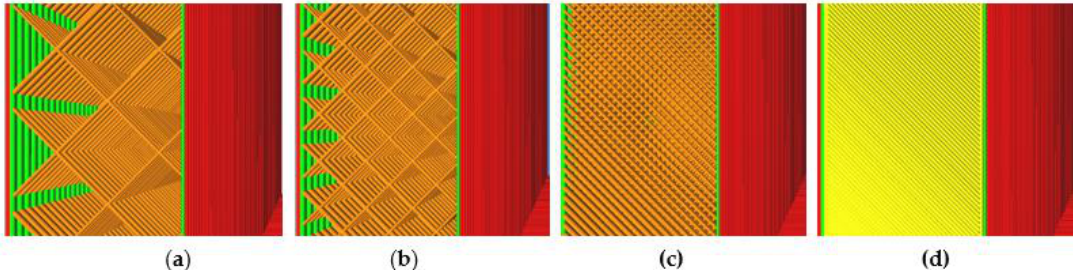
Figure 6. Cura slicing screenshots of the lower left-hand corner of the POSCAS varying the infill density ( a ) 10%, ( b ) 20%, (c) 50% and ( d ) 100%. The red layers are external shell, green is the inner wall, and orange is the infill, which is yellow in the 100% case as every layer is treated as a top/bottom layer.